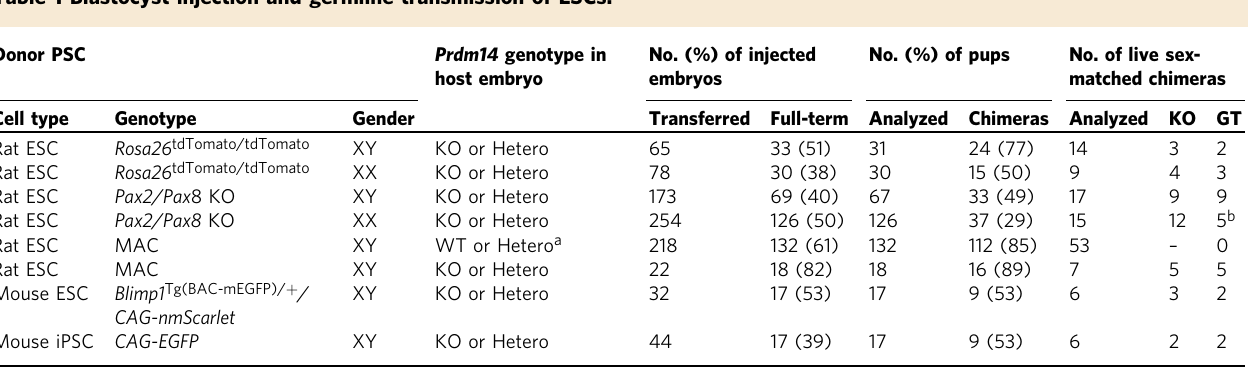
Table 1 Blastocyst injection and germline transmission of